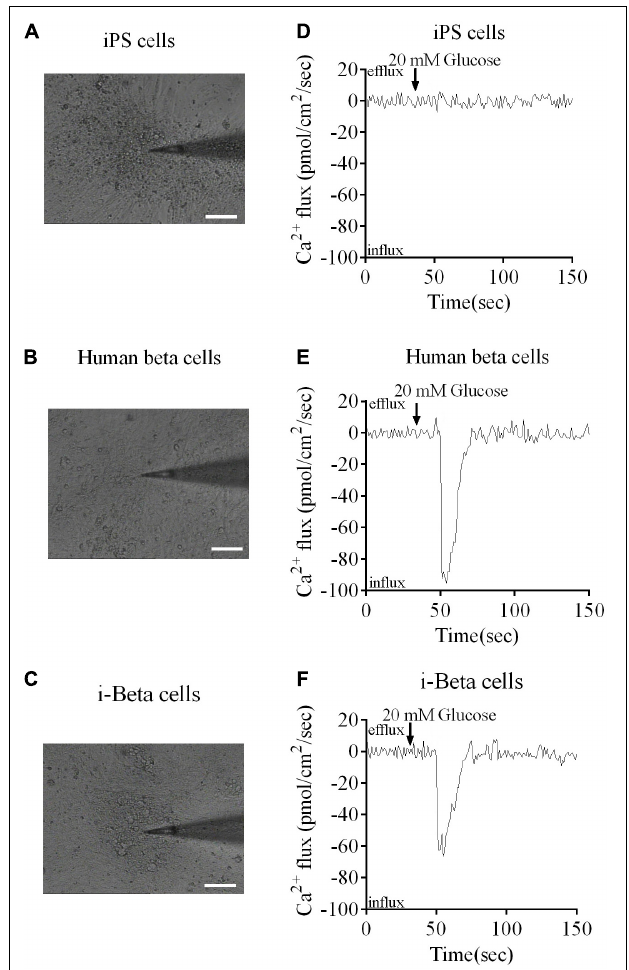
FIGURE 4 | Ca 2 + fluxes in human beta cells, i-Beta cells and iPSCs. (A–C) Images of human beta cells, i-Beta cells, and iPSCs analyzed by the non-invasive micro-test technique. (D–F) . Real-time normalized glucose-induced Ca 2 + flux patterns of human beta cells, i-Beta cells, and iPSCs. Ca 2 + influx was observed in human beta cells and i-Beta cells, but not iPSCs, after addition of 20 mM